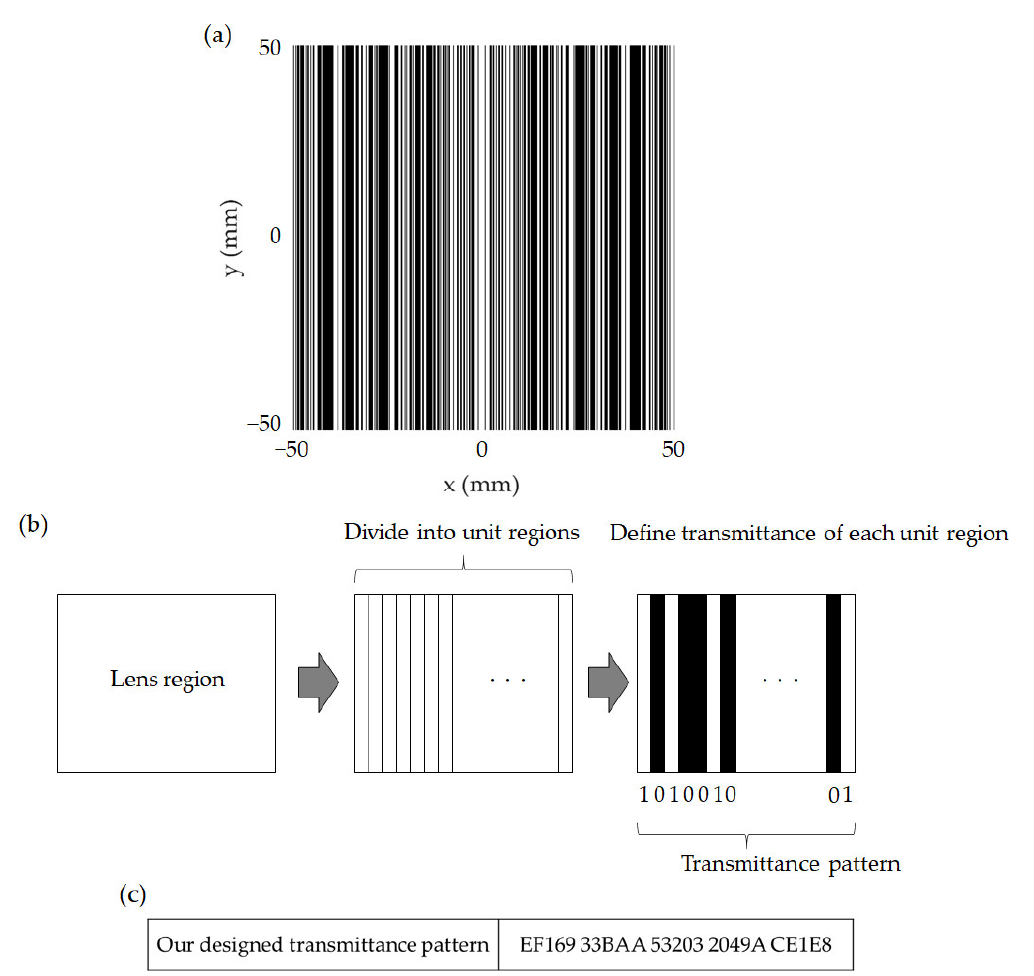
Figure 2. ( a ) Schematic of our designed THz-CSOL where the black and white regions correspond to opaque and transparent areas, respectively. ( b ) Steps of the transmittance pattern design process. ( c ) Hexadecimal representation of the transmittance pattern of our symmetrically designed lens from the center position to the edge of the lens. In addition to the desired focal length of z = 70 mm, the THz-CSOL was also optimized to satisfy the conditions at z = 68, 69, 71, and 72 mm. The optimization algorithm used was binary particle swarm optimization (BPSO) [45]. The algorithm flowchart is shown